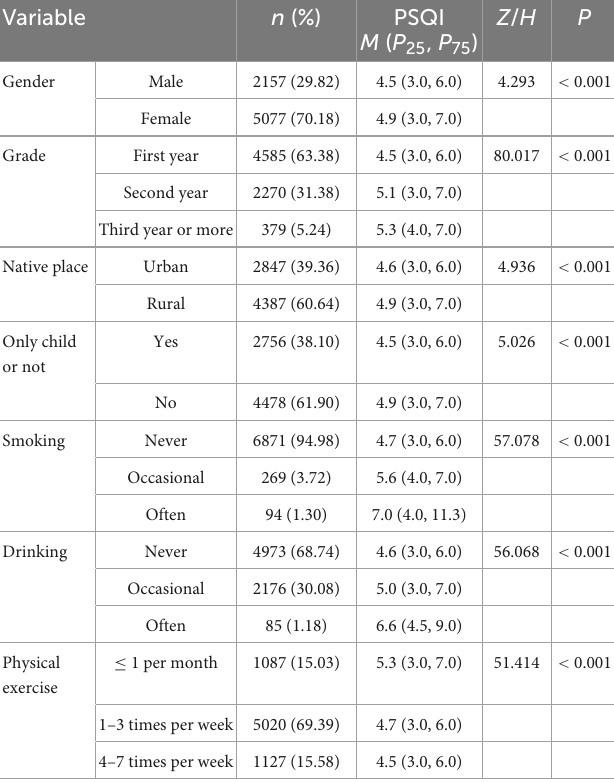
TABLE 2 Psychological resilience scores of college students with different characteristics.